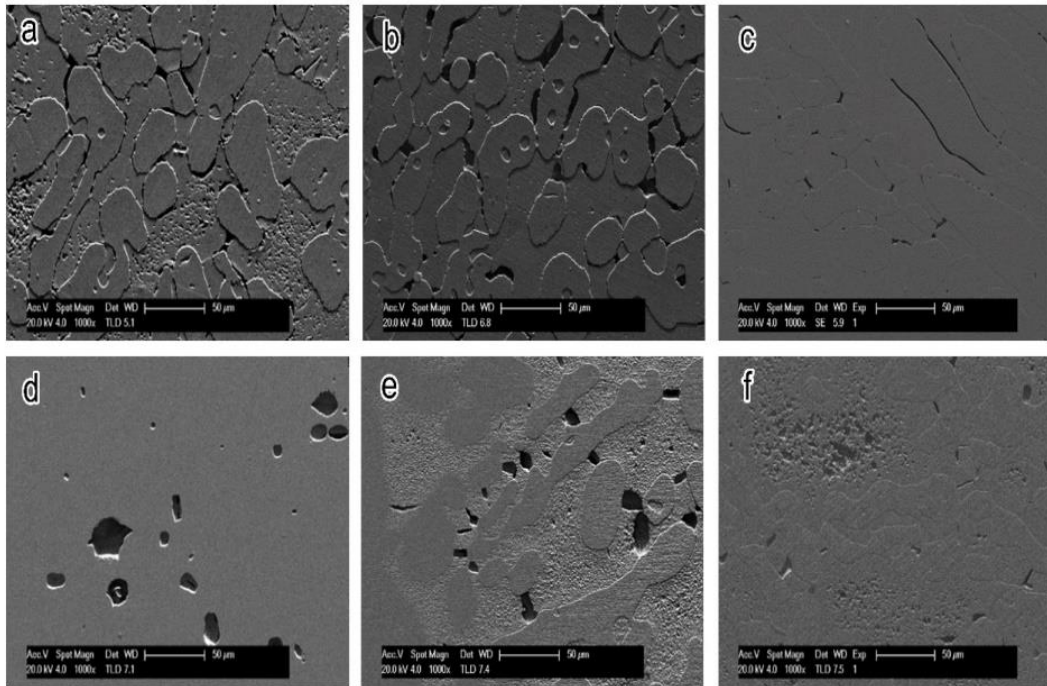
Figure 13. SEM photographs of corrosion morphology of S32750 stainless steel at different annealing temperatures for 35 min after polarization tests: ( a ) 950, ( b ) 1000, ( c ) 1050, ( d ) 1100, ( e ) 1150, and ( f ) 1200 °C.